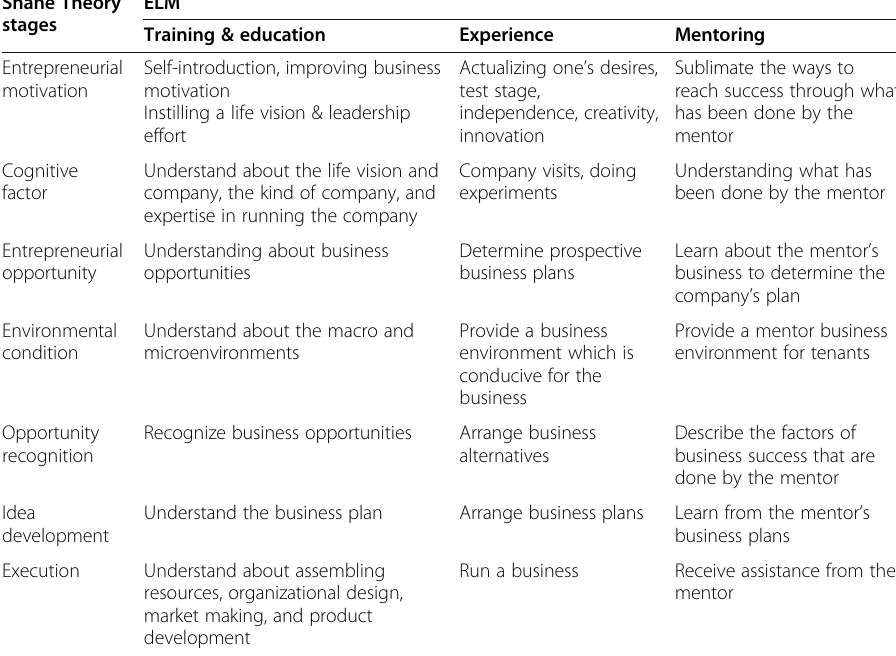
Table 1 Framework of research Shane Theory